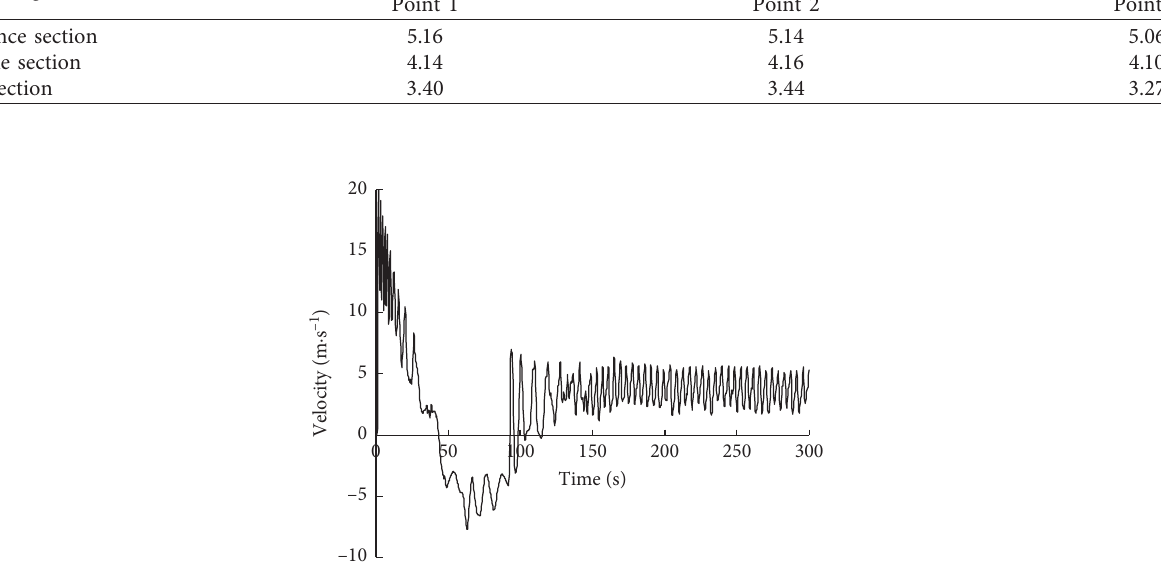
Table 4: Comparison of flow velocity (ms − 1 ) in the cross channel when the fire occurs in different locations. Measuring